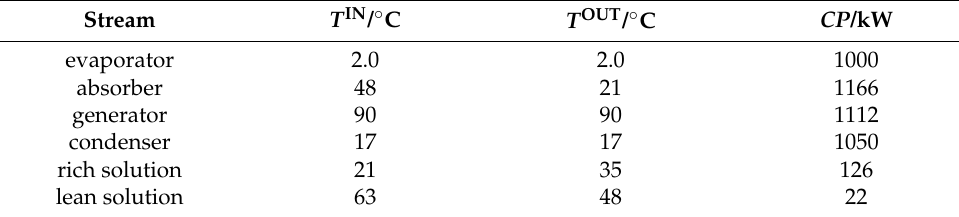
Table 7. Derived stream from the AC for case study 2.